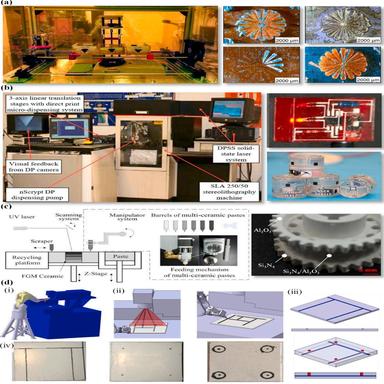
SLA-based multi-material additive manufacturing equipment and technology for ceramics: (a) multi-material SLA equipment and printed micron-sized twocomponent prototype, (b) hybrid additive manufacturing system of SLA and DP with printed structural components of embedded electronic circuits, (c) schematic diagram of the multi-material additive system integrated with SLA and robotic manipulator along with the printed ceramic components of gradient functionality, and (